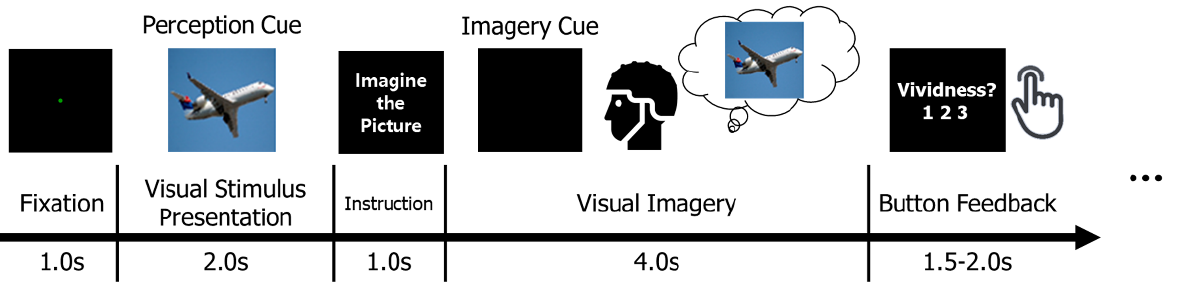
Figure 2. Experimental paradigm of visual perception (VP) and visual imagery